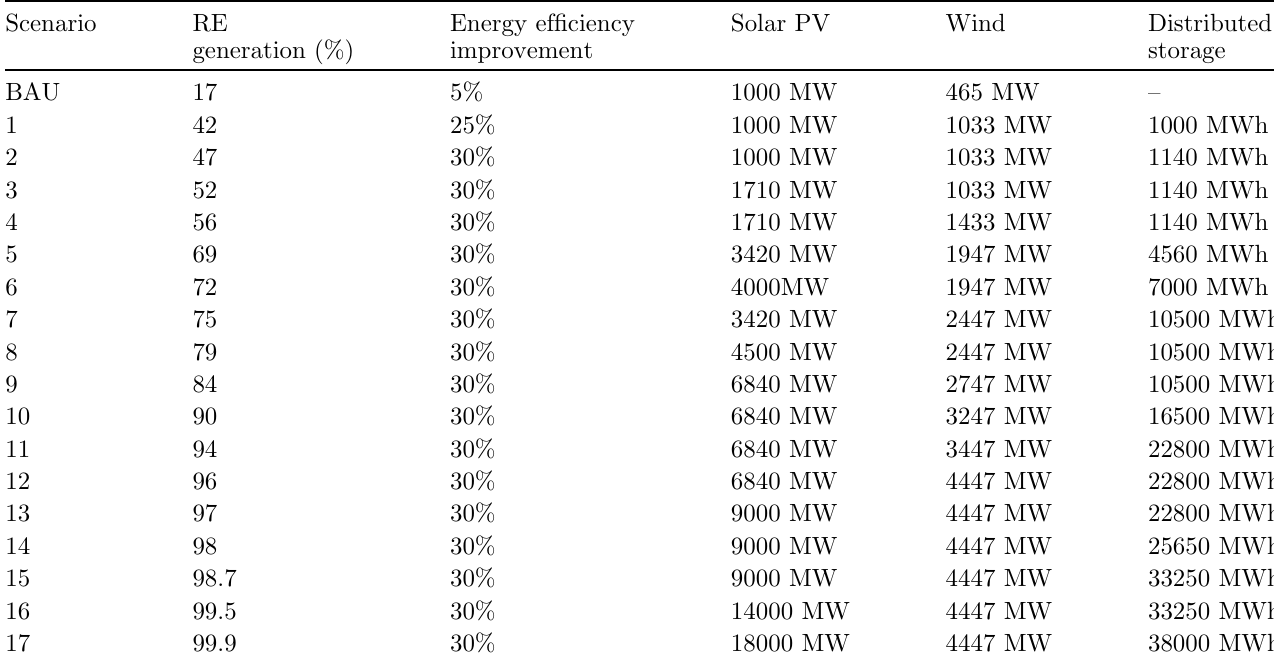
Table 1. Current installed capacity for the SWIS electrical grid (BAU) and renewable energy capacity for each partial renewable scenario ( < 100% RE) by technology